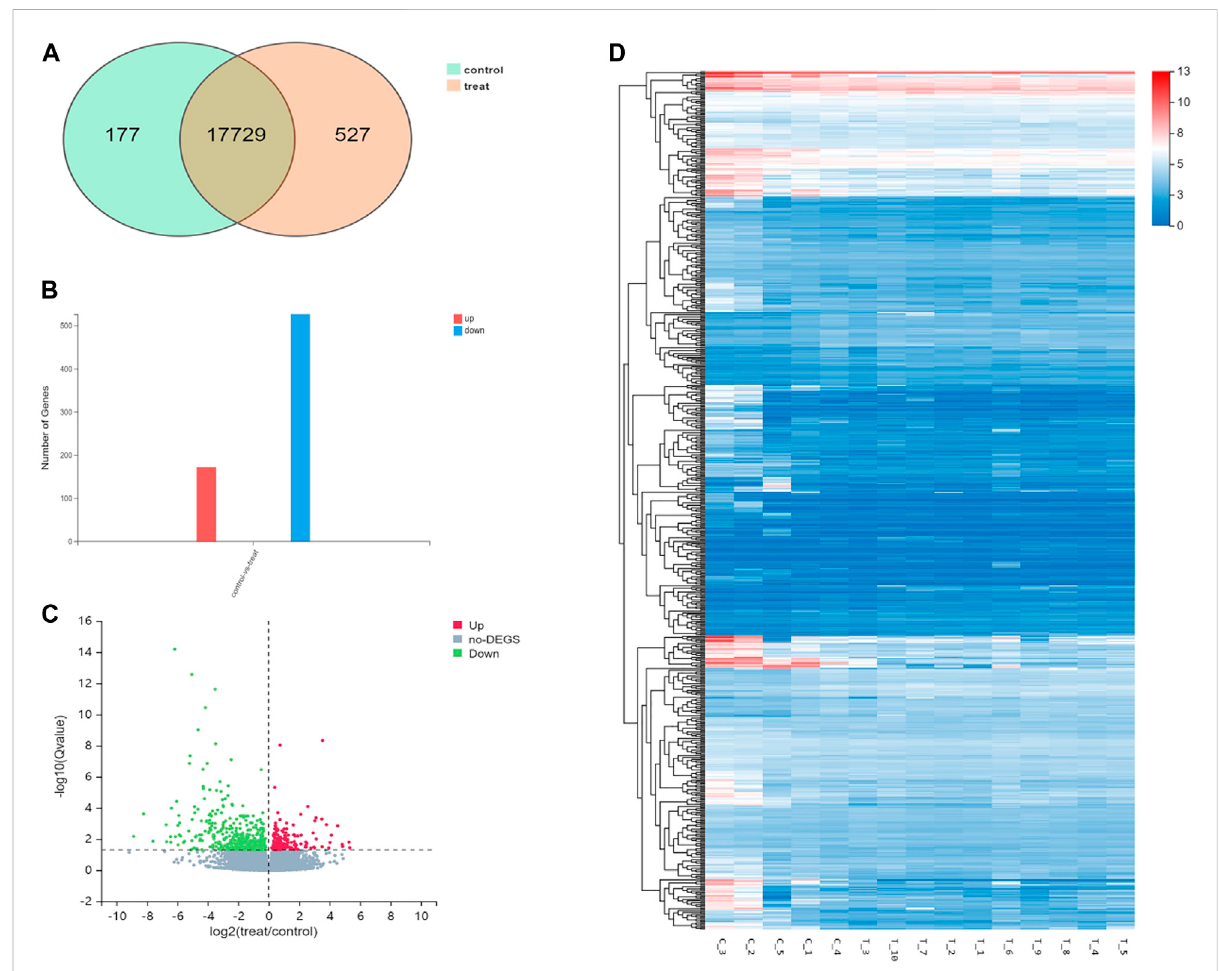
Differential gene expression in the control group and the experimental group. (A) . The intersecting genes in two groups. (B) . Number of differentialgenes. (C) .Differential genevolcanomap. (D) .Hierarchical